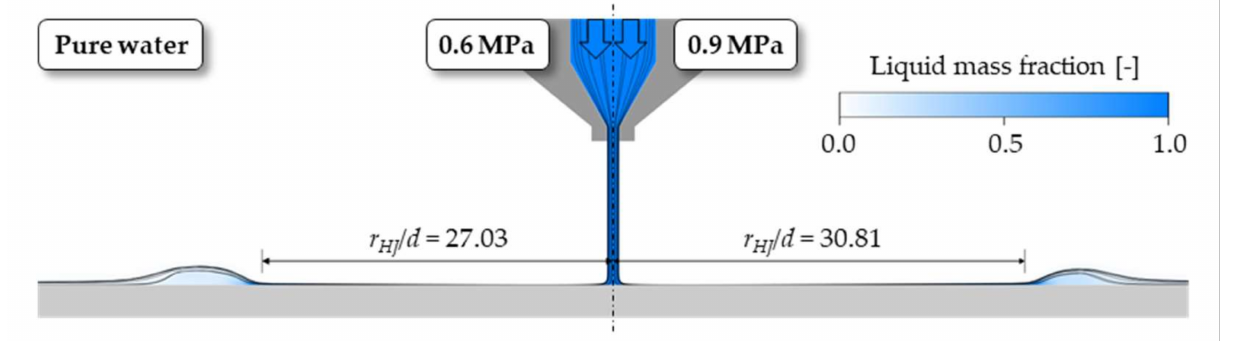
Figure 11. Dimensionless radial position of the hydraulic jump for the cases of the inlet pressures of 0.6 ( left ) and 0.9 MPa ( right ) for pure